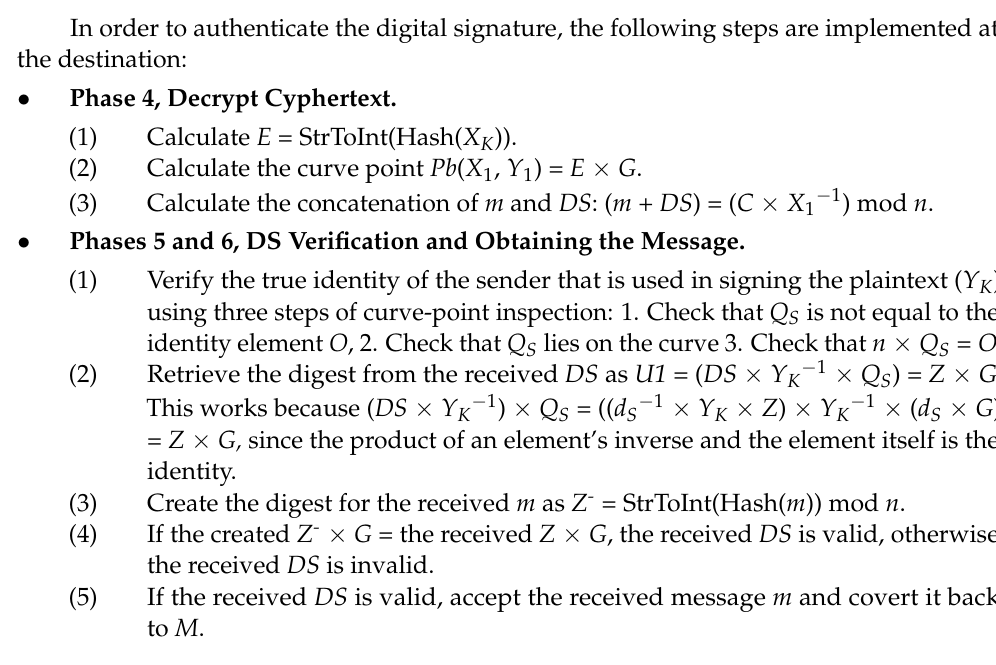
Figure 4. The six phases in the proposed digital signature.